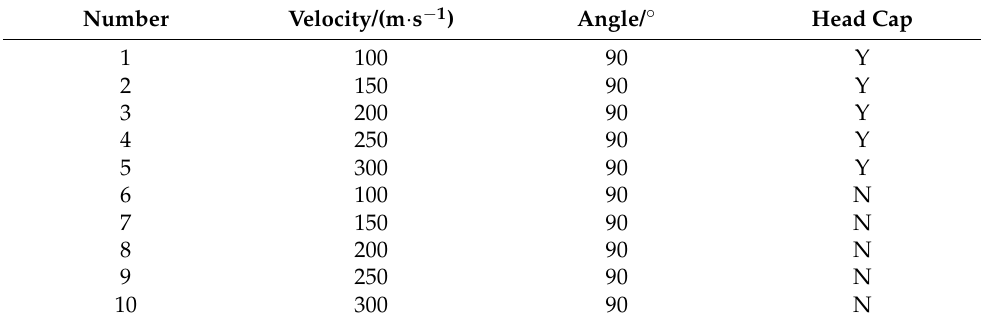
Table 9. Situations of simulation.